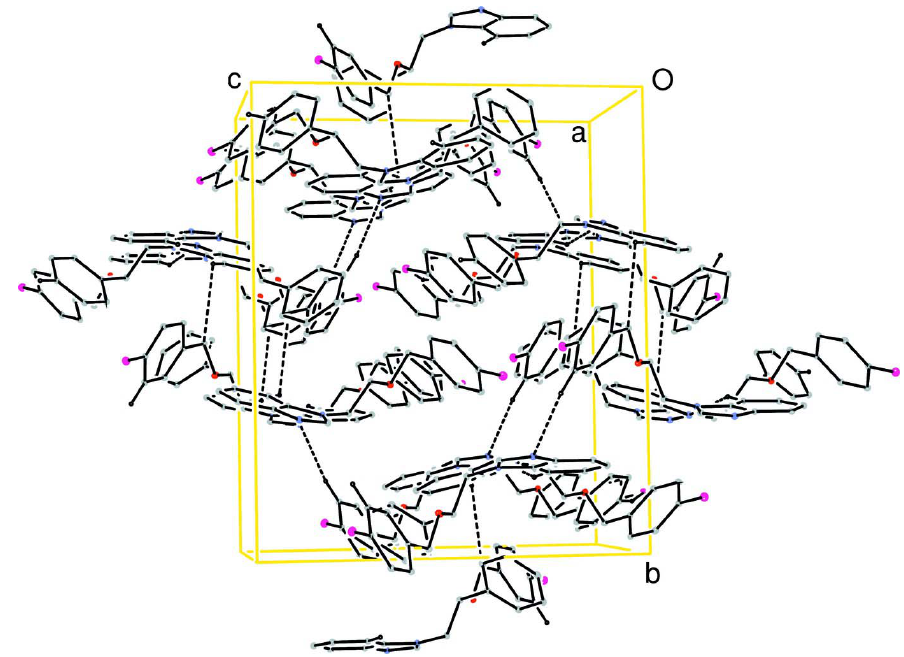
Figure 2 A packing diagram of (I). Hydrogen bonds are shown as dashed